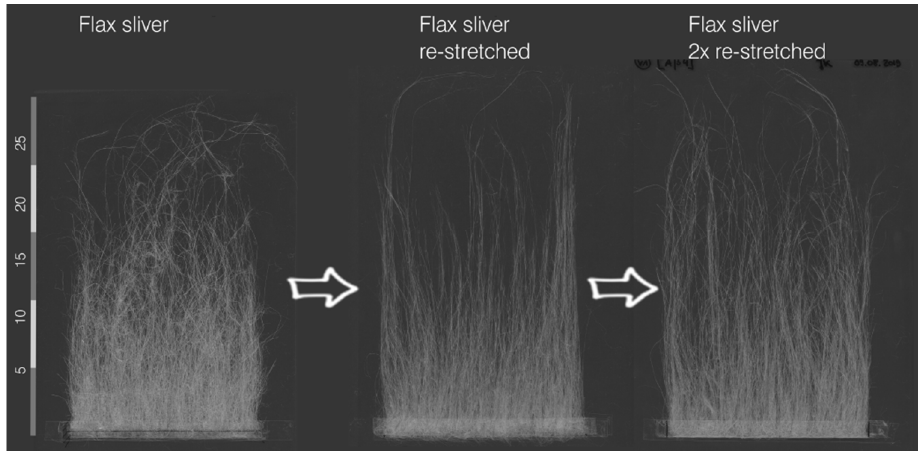
Figure 5. Length distribution depending on re-stretching of the sliver.